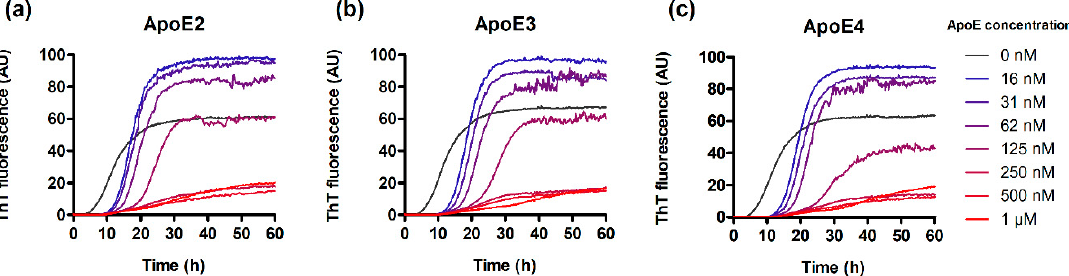
Figure 1. Thioflavin-T (ThT) binding kinetics of 5 µM islet amyloid polypeptide (IAPP) in the presence of the three apolipoprotein E (ApoE) variants: ApoE2 ( a ), ApoE3 ( b ), and ApoE4 ( c ). The ApoE variants were used at the concentrations indicated in the figure.